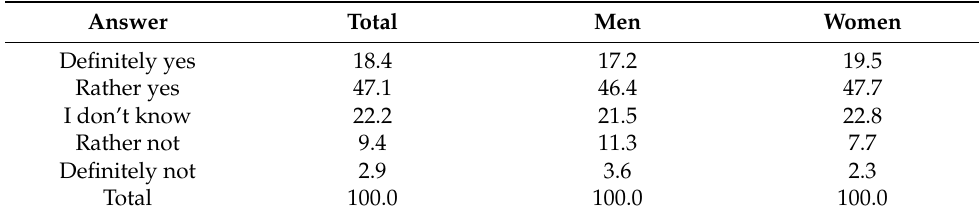
Table 3. The willingness to pay for the Polish origin of food products